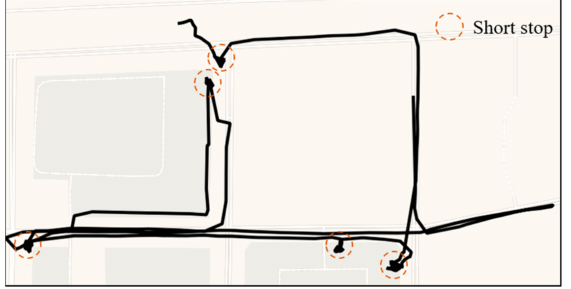
Figure 4. An example of a trajectory of frequent short stops. Each red circle indicates a short stop. To identify this behavior, a spatiotemporal clustering algorithm is chosen to detect high-density clusters with strong aggregation in the spatiotemporal dimension. More specifically, the neighborhood of a spatiotemporal point is defined as the longest continuous subsequence starting from this point. The spatial distance from the starting point is less than the specified distance threshold d 1 for all points in the sequence. The neighborhood of point P i can be expressed